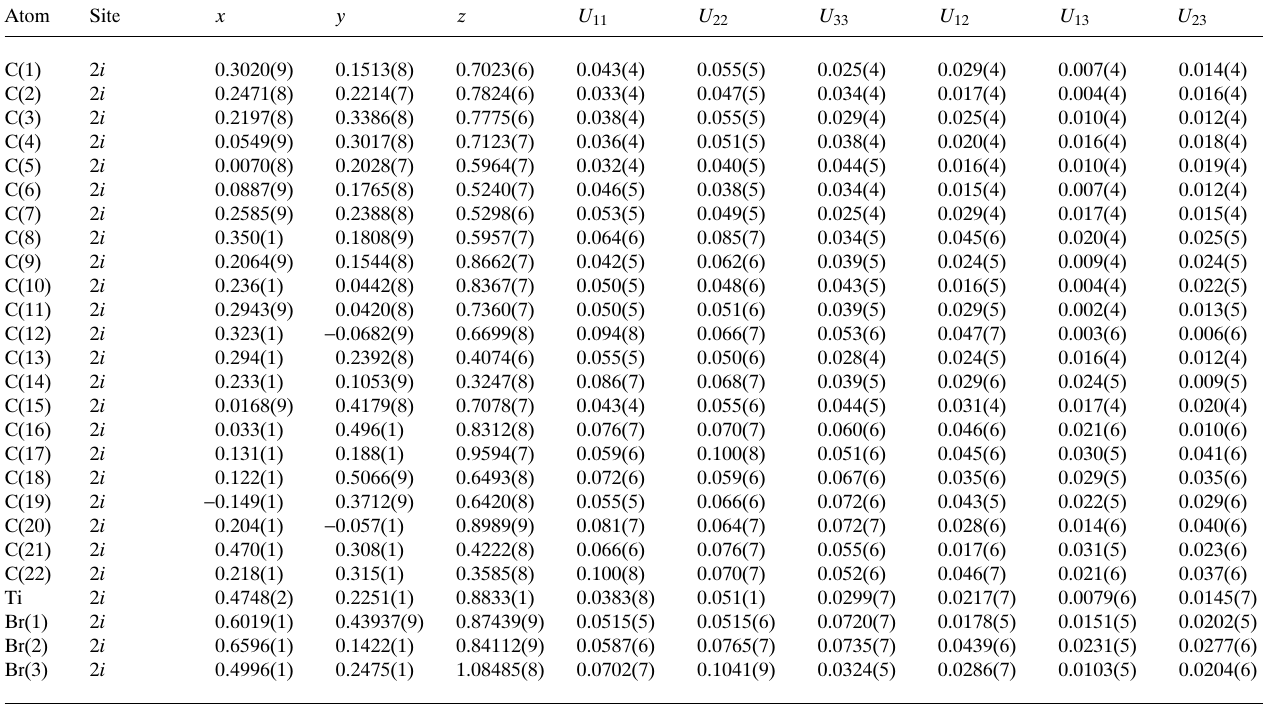
Table 3. Atomic coordinates and displacement parameters (in Å 2 ) .